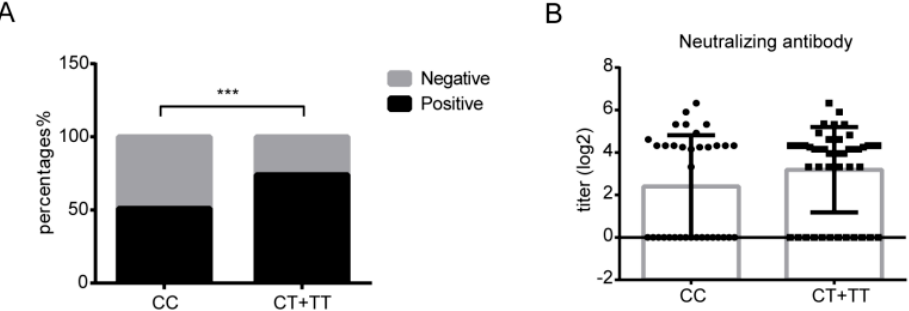
Figure 6. The rs12252 CC genotype is associated with lower positivity frequency of SARS-CoV-2 neutralizing antibody. ( A ) The positivity frequency of neutralizing antibodies in patients with different rs12252 genotypes in two to three weeks after symptom onset ( p = 0.0008). ( B ) Neutralizing antibody titers in CC and CT/TT patients. ***, p < 0.001.